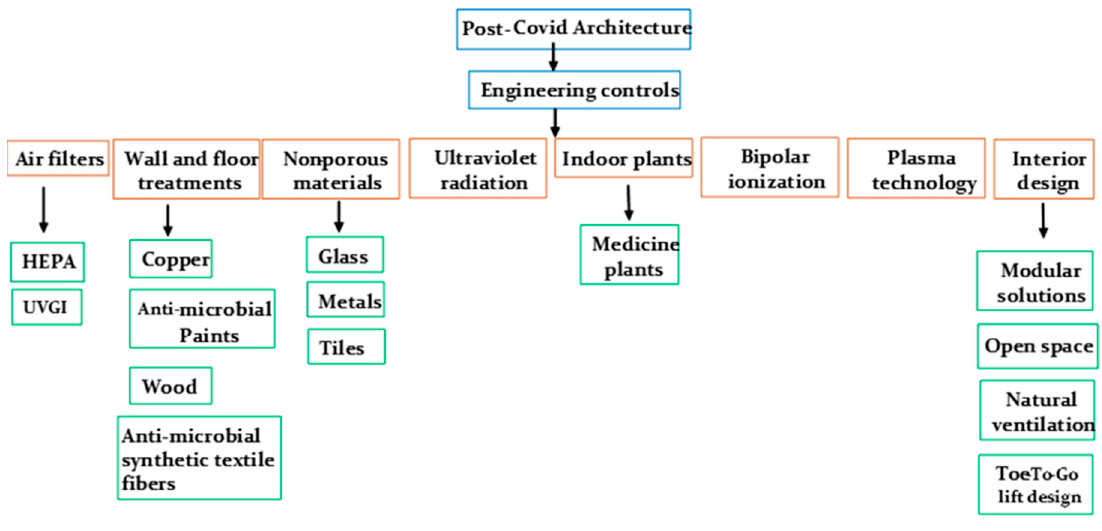
Figure 2. Engineering controls to reduce the transmission of the COVID-19 disease.